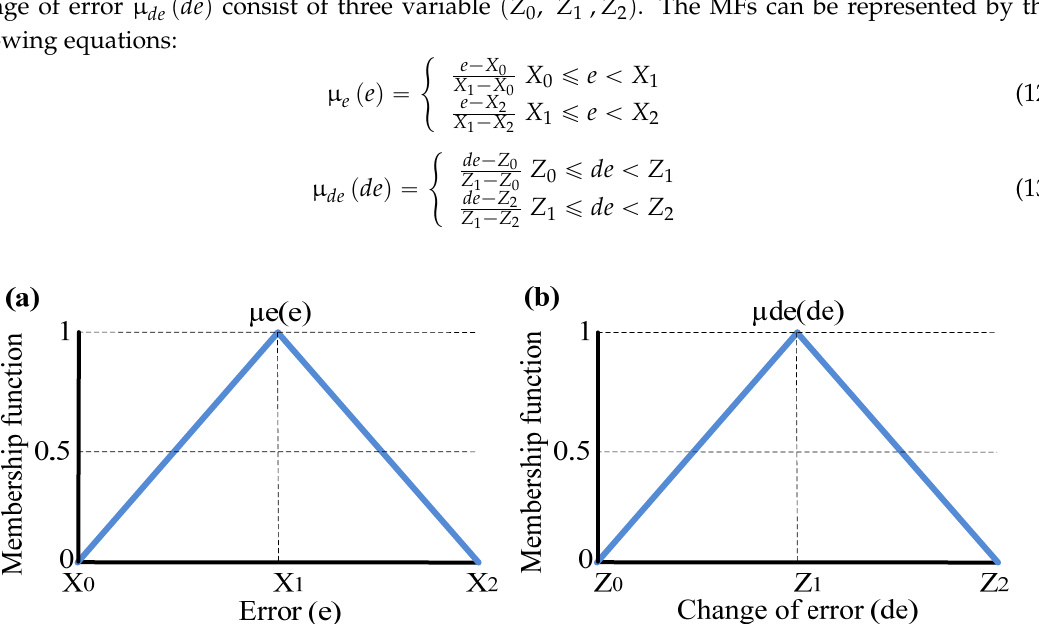
Figure 3. Triangular representation of membership functions (MFs). ( a ) Error; ( b ) change of error.